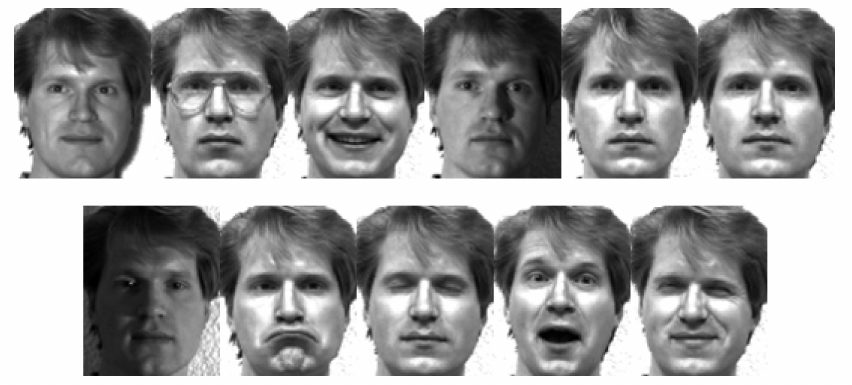
Figure 7. Face image of an individual in Yale face